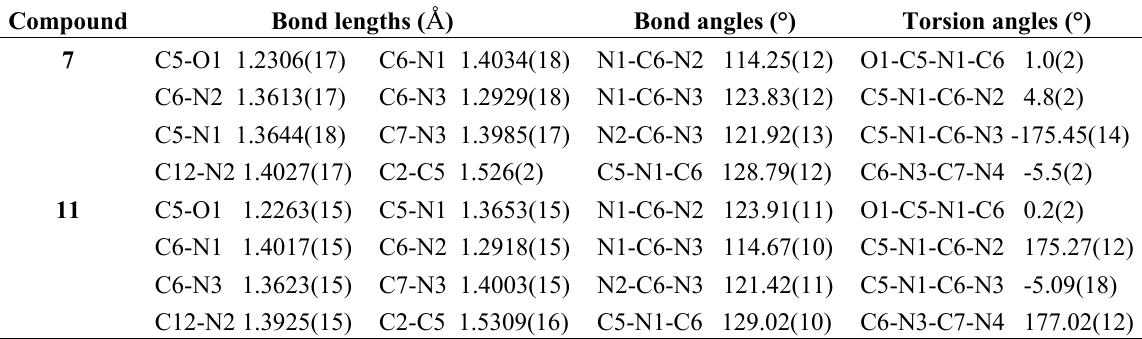
Table 3. Selected bond lengths, bond angles and torsion angles for compounds 7 and 11 . Compound